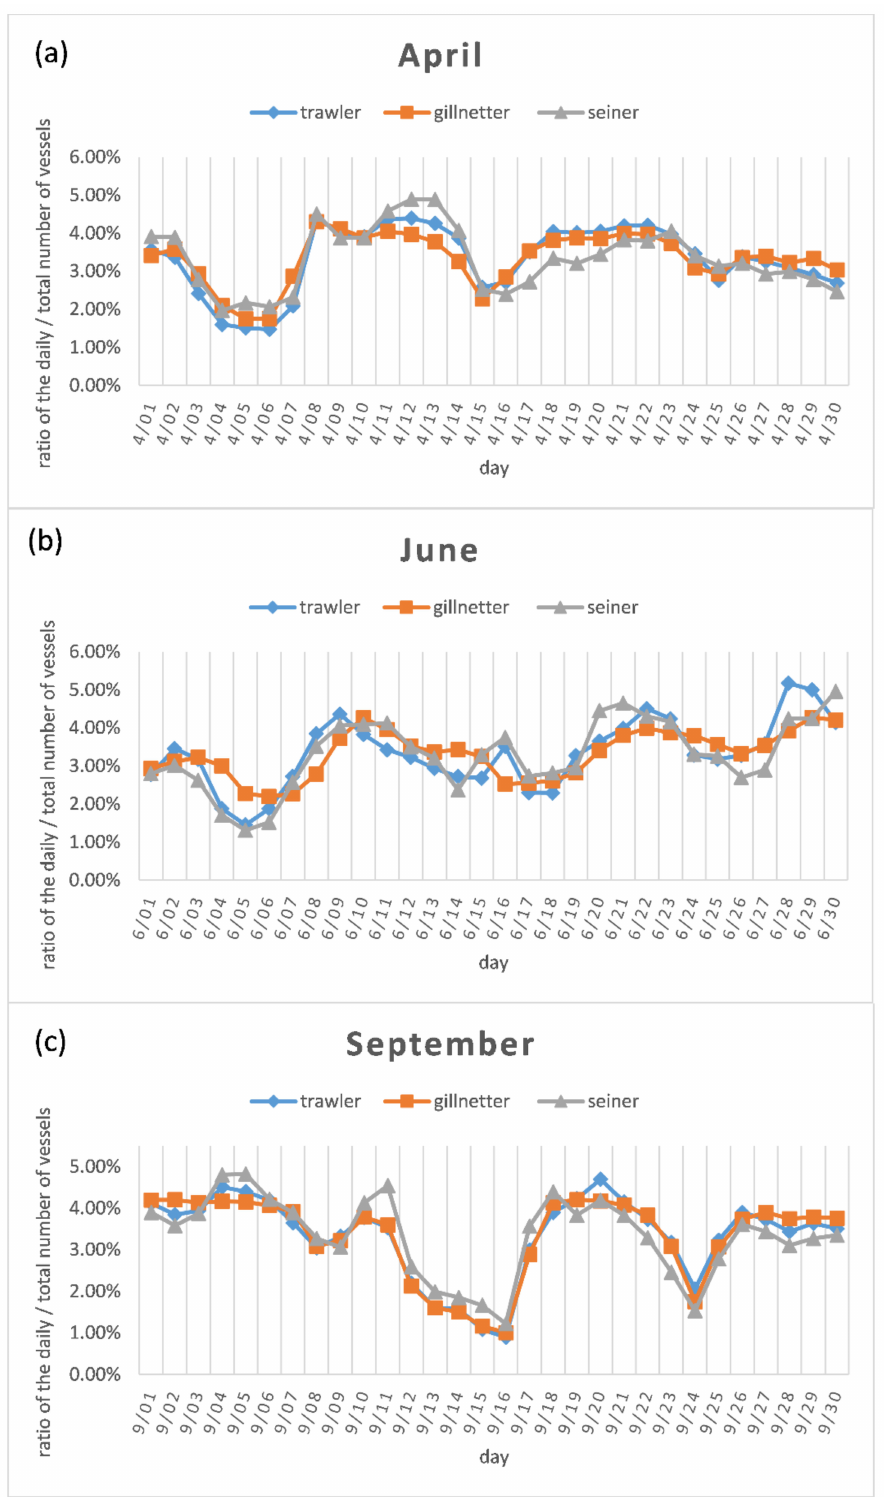
Figure 18. Statistics for Chinese fishing vessels per day in April ( a ), June ( b ) and September ( c ). For Chinese fishing vessels (Figure 18), we found that in April and September, the change trend in the daily number was quite consistent for the trawlers, gillnetters and seiners, while there was a slight difference in June. The Chinese vessels showed little weekly variation but were influenced by traditional Chinese festivals. In China in 5 April 2018 was Tomb Sweeping Day (the holiday period was from 5 to 7 April), and June 18